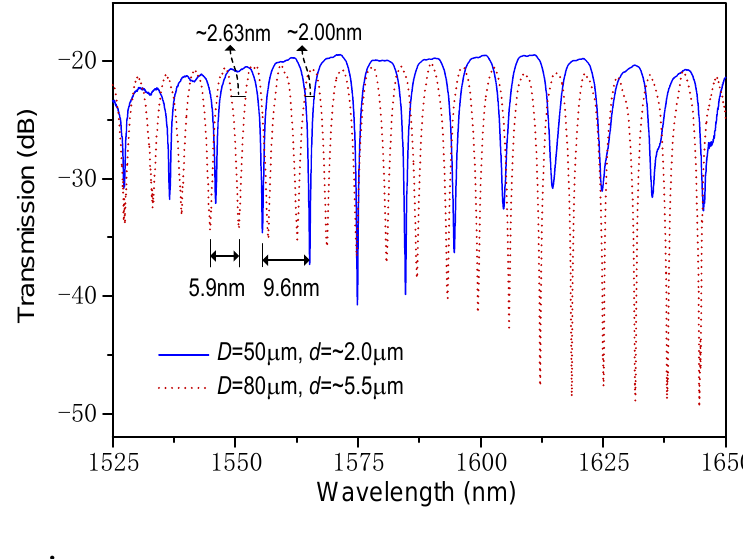
Figure 2. Transmission spectra of our device with different sizes of the CrNi wire and the